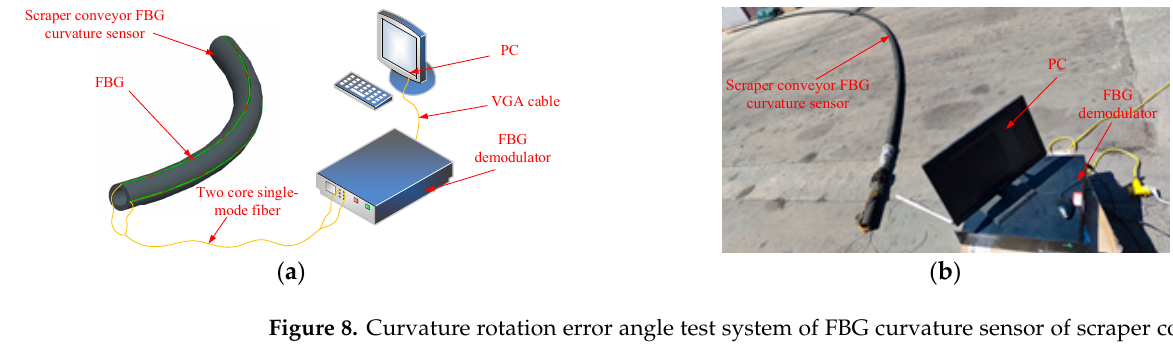
Table 2. Initial center wavelength and curvature sensitivity coefficient of FBG curvature sensor of